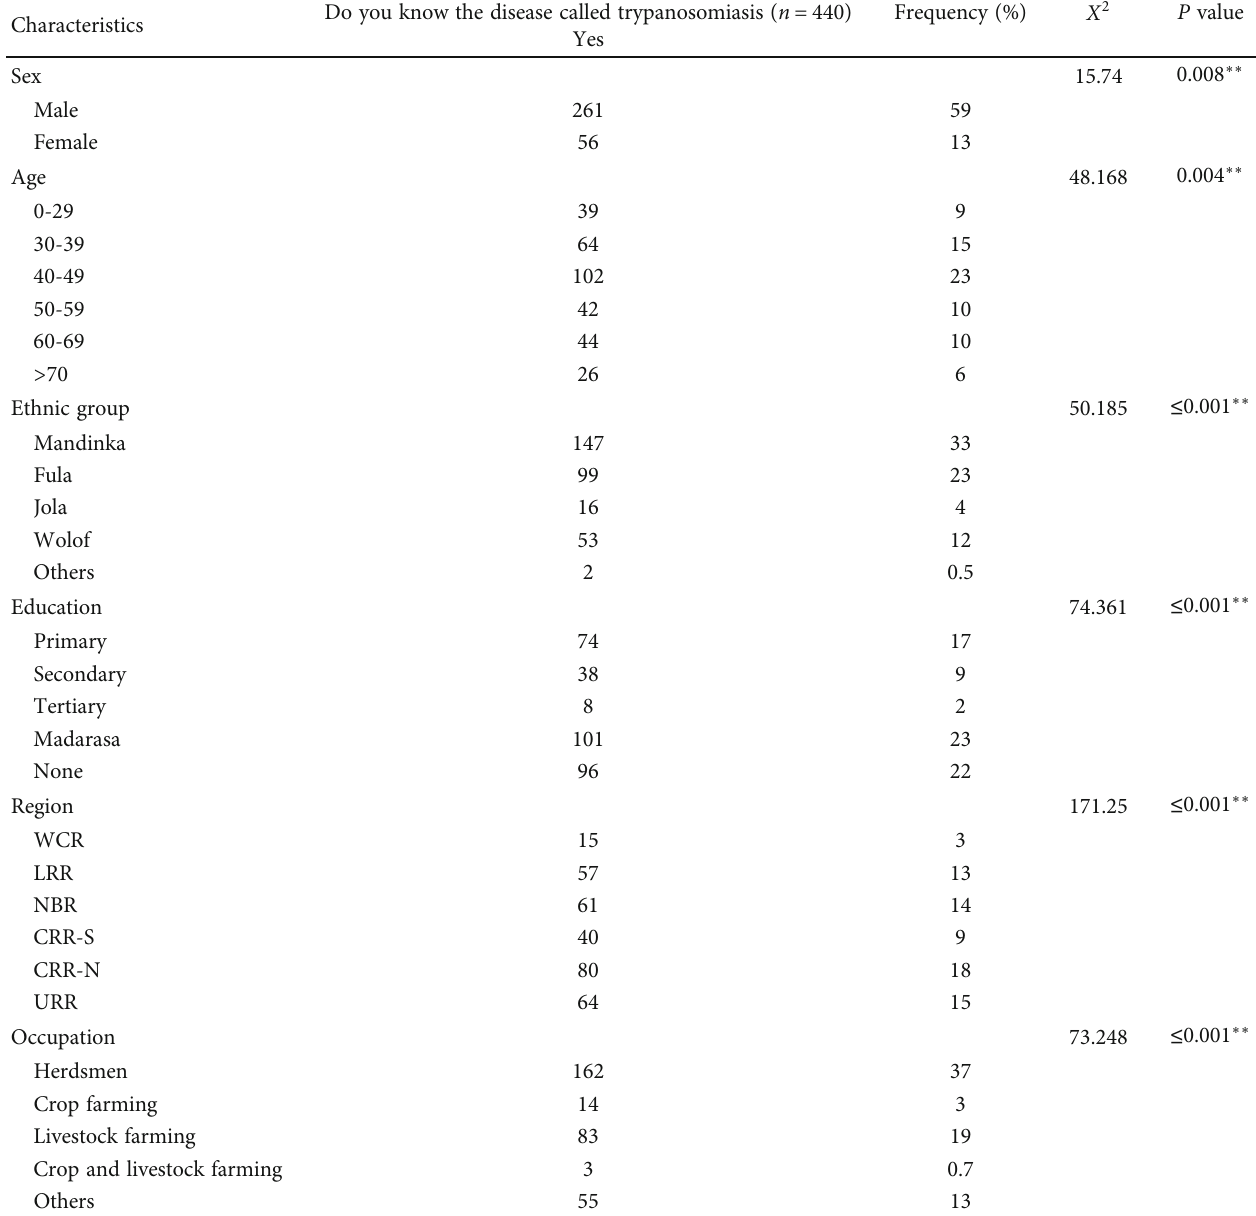
Table 4: Characteristics of livestock owners and knowledge of African animal trypanosomiasis in The Gambia, 2021.